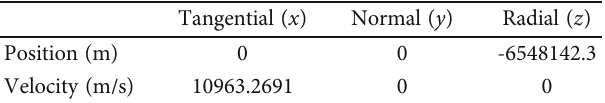
Table 2: Spacecraft departure status in orbital coordinate system. Table 3: Range of values for TLI